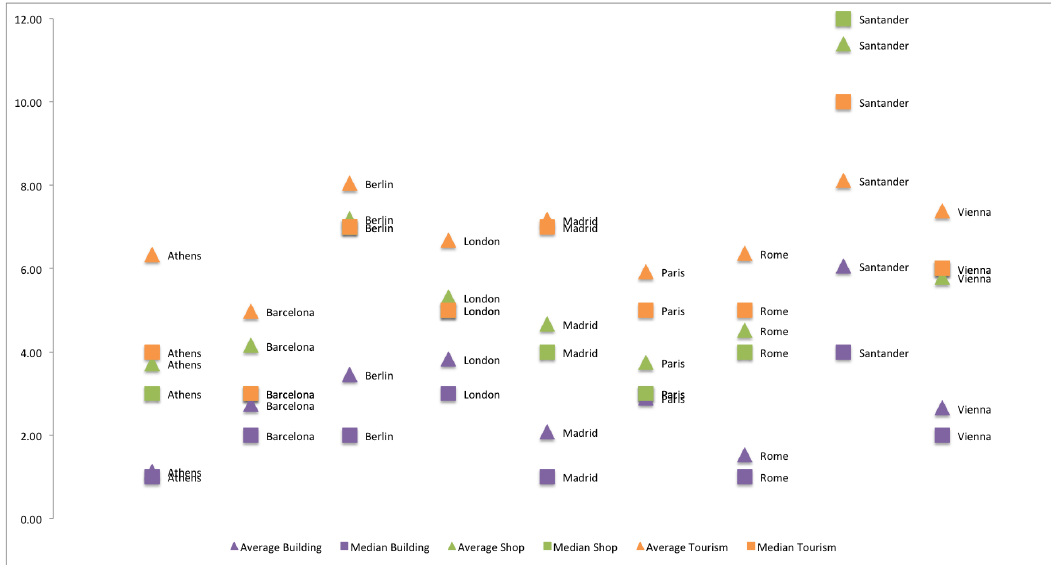
Figure 26. Consistency study of tourism in Europe. Standard deviation of the tag number.